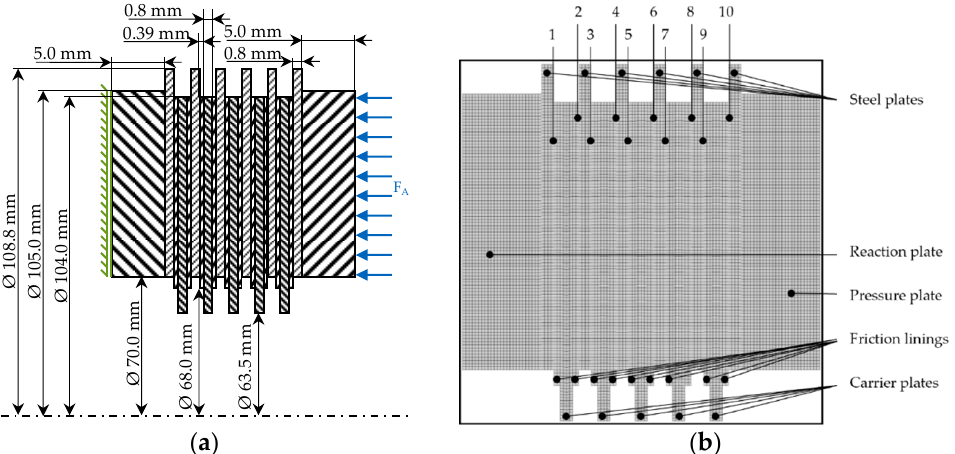
Figure 2. ( a ) Geometrical dimensions and mechanical boundary conditions [20] and ( b ) FE model of the multi ‐ plate clutch [20].